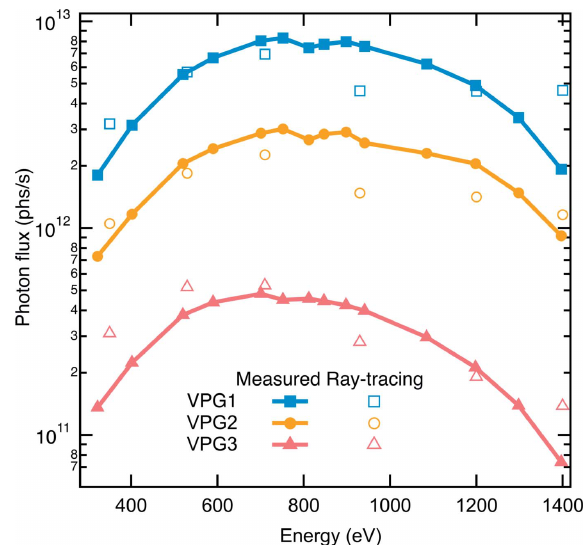
Figure 8 The measured (filled) and ray-tracing (open) monochromatic photon flux as a function of energy with the exit slit opening of 10 m m at a ring current of 300